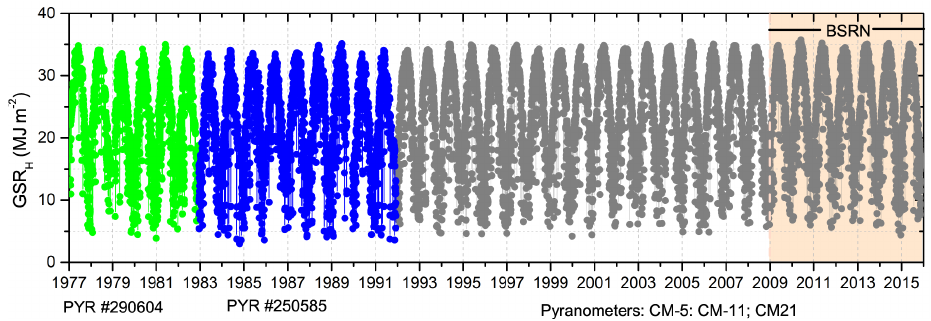
Figure 5. Daily GSR H data time series between 1977 and 2015 at IZO. The green and blue dots correspond to the measurements performed with PYR #290609 and #250585, respectively, between 1977 and 1991, and the grey dots represent the measurements performed with different pyranometers (CM-5, CM-11 and CM-21) between 1992 and 2015.